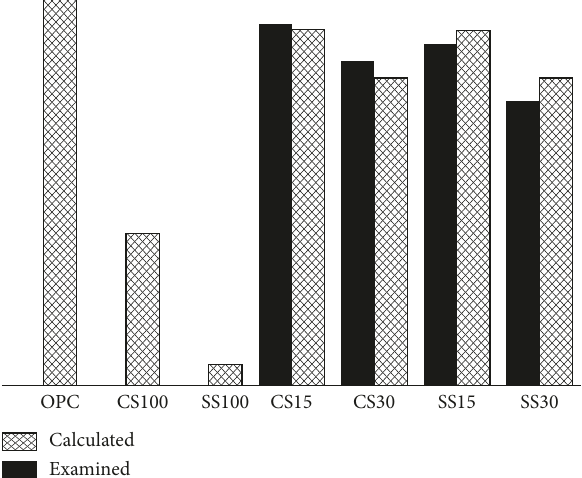
Figure 3: The examined and the calculated cumulative heat for different slag